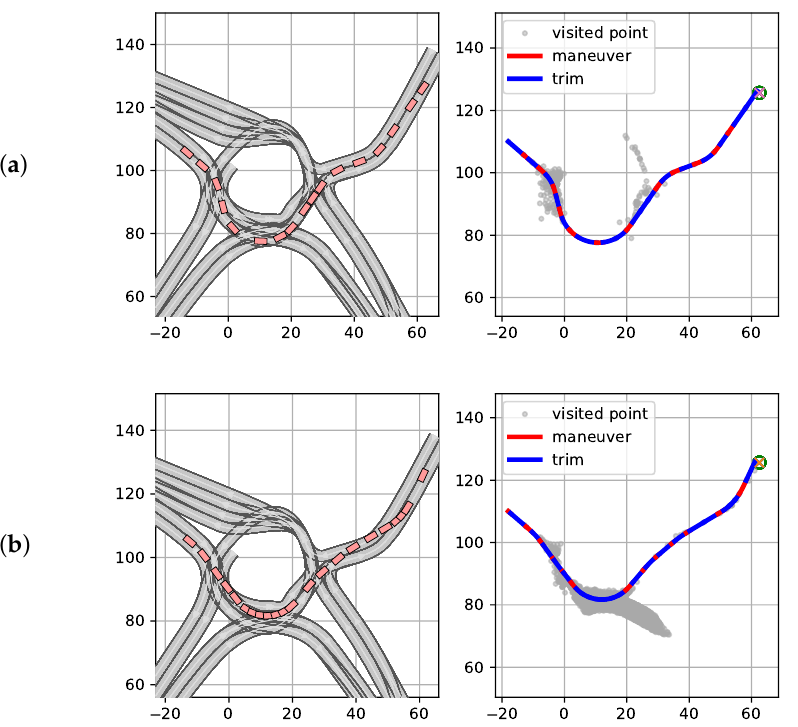
Figure 14. Trajectories for the automaton with 26 trims: ( a ) handcrafted; ( b )